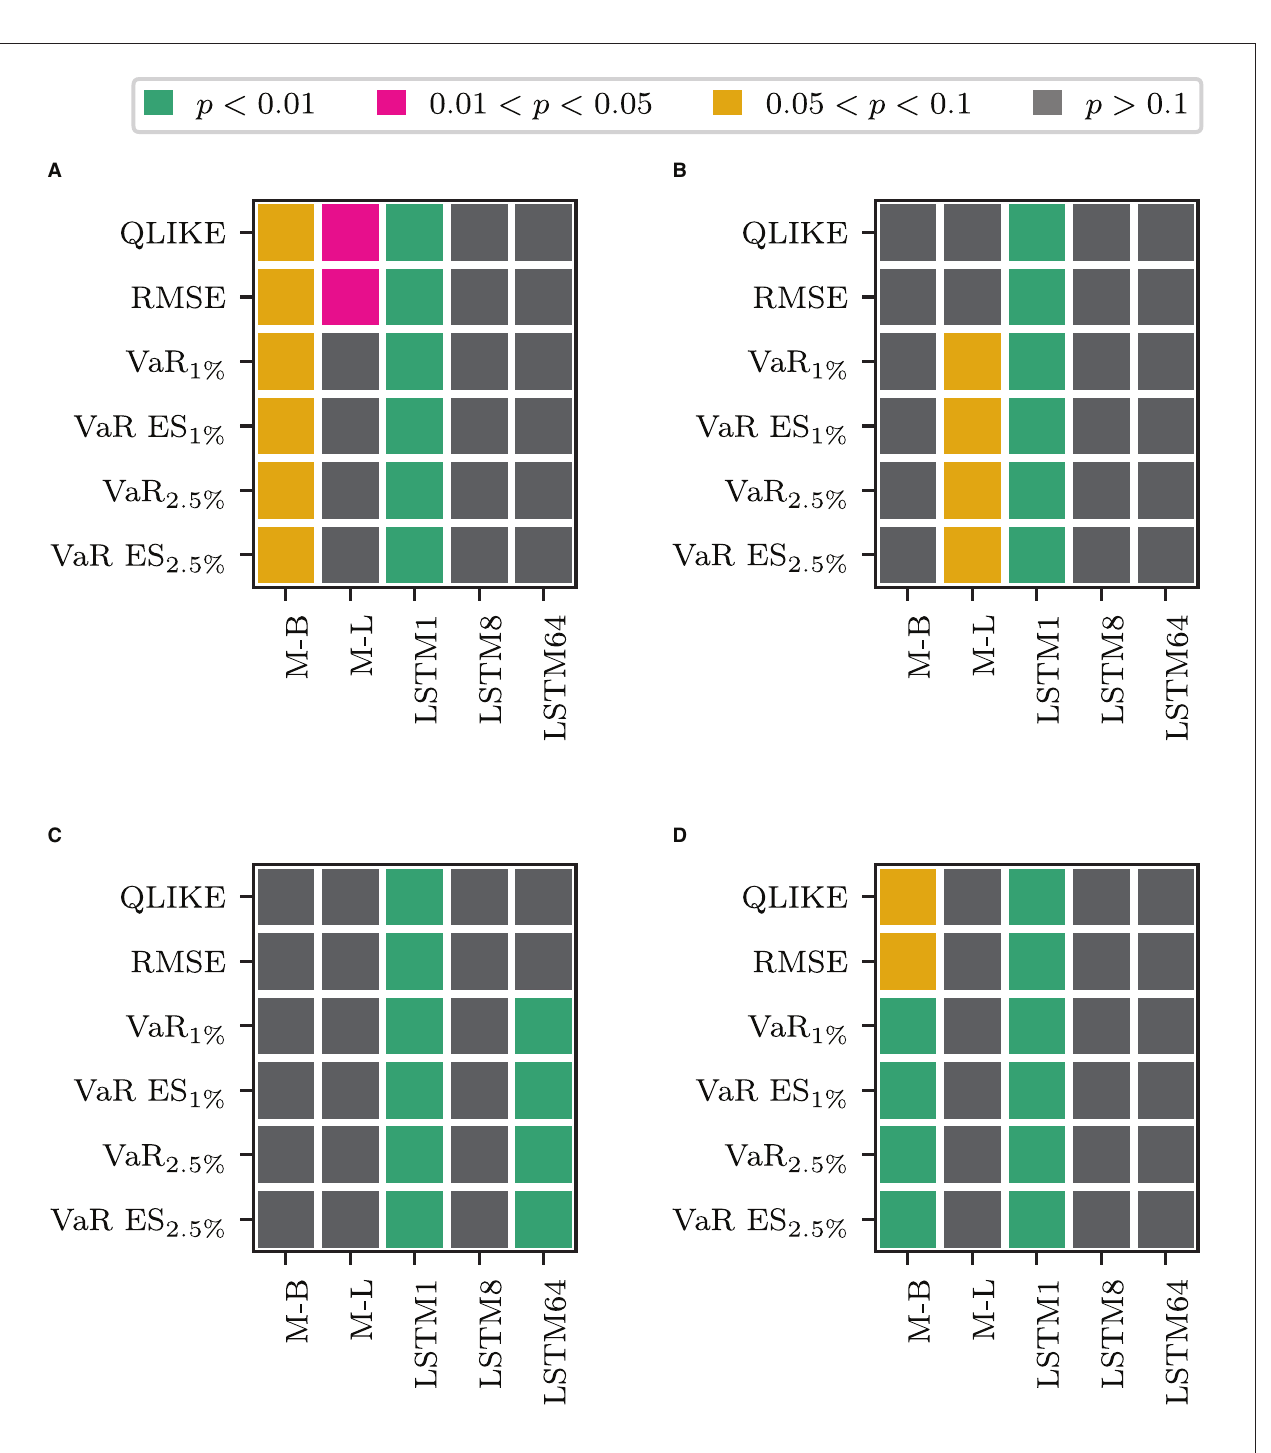
lower losses than the HAR O . This is in line with Rahimikia and Poon (2020a), who also find that the CHAR is performing best among the HAR family models. Apart from the CHAR